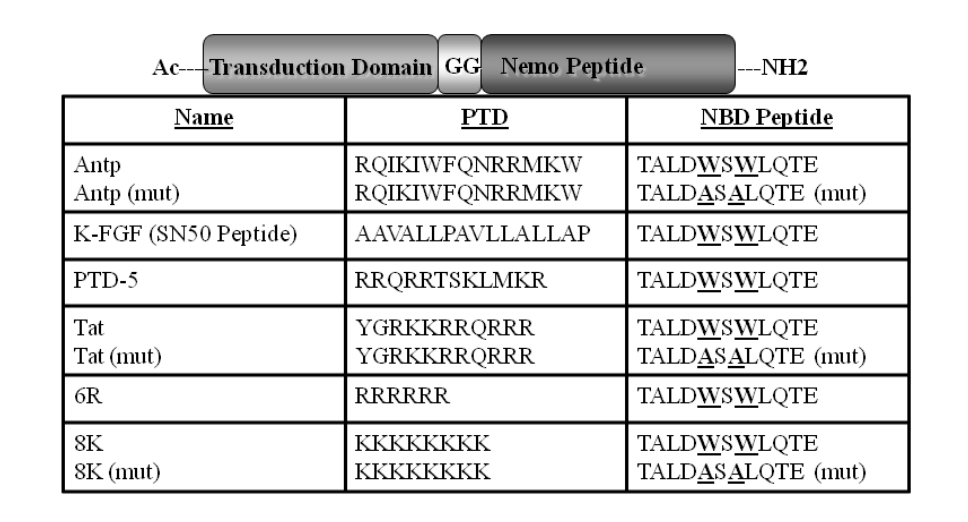
Figure 1. Structure of the PTD-NBD fusion peptides. The different PTDs tested as well as the sequences for wild type and mutant NBD peptides are indicated. The PTD and the NBD domain were separated by a diglycine (GG)